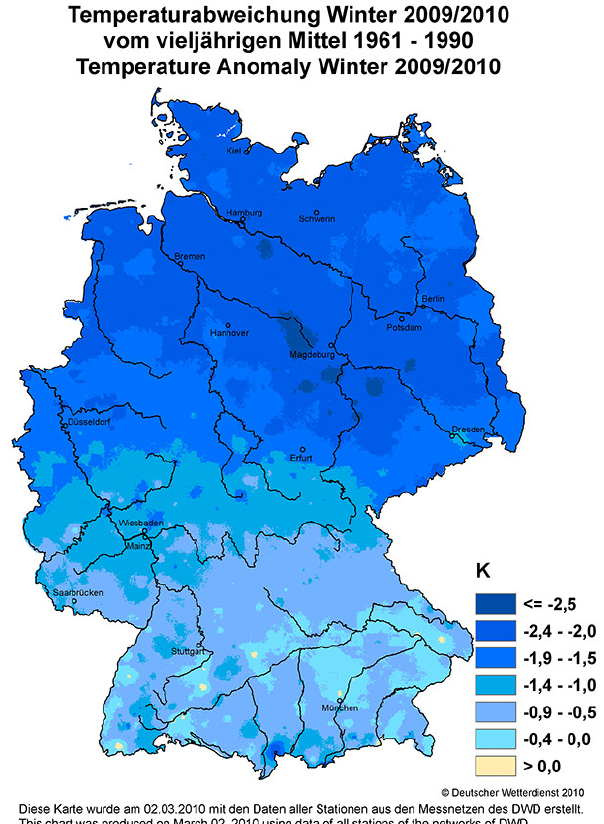
Figure 1. Temperature anomaly in winter 2009/10 with respect to the multi-year average from 1961 to 1990. Figure created by Deutscher Wetterdienst (German weather service, DWD) and downloaded from https://www.dwd.de/EN/ourservices/ klimakartendeutschland/klimakartendeutschland.html?nn=495490 (last access: 1 April